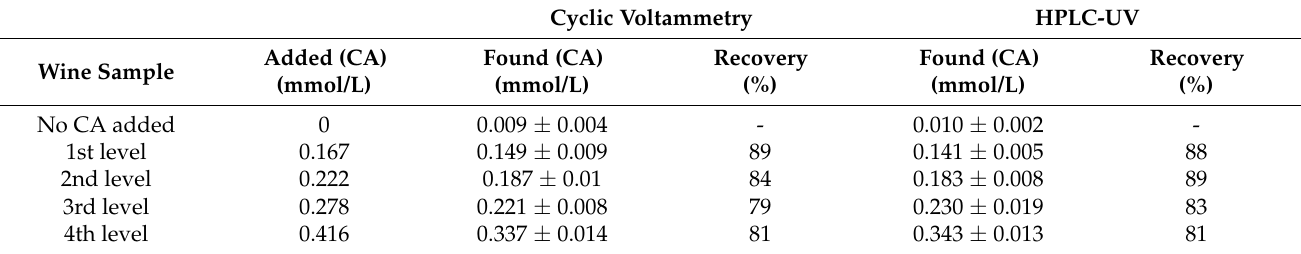
Table 1. Added and recovered concentration of CA from wine samples using the MIP-CA/cyclic voltammetry and the HPLC-UV